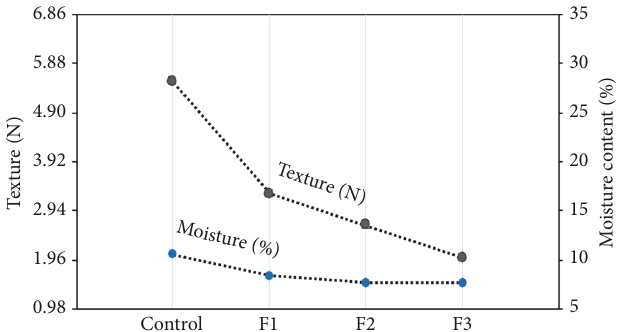
Figure 3: Texture (force (N)) and moisture content (%) for each snack formulation.